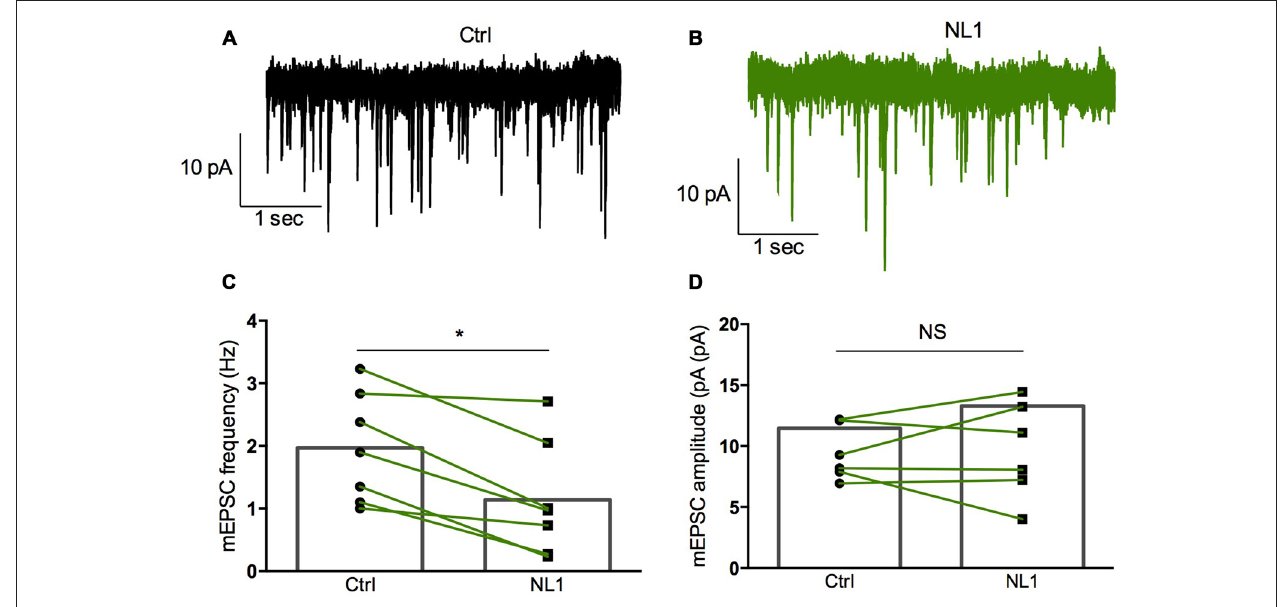
FIGURE 4 | Miniature EPSCs (mEPSCs) are inhibited by ecto-NL1. (A) Example of mEPSC recorded in a pyramidal neuron from CA3 region. Five superimposed recordings. (B) Recording from the same neuron after a single puff of ecto-NL1 near the apical dendrite of the recorded neuron (five superimposed traces). Note the strong decrease in the frequency of mEPSCs. (C) Mean frequency of mEPSCs in control conditions and after ecto-NL1 puff. Significant decrease (mean frequency of mEPSCs in control conditions: 1.97 ± 0.3 Hz; after ecto-NL1: 1.14 ± 0.3 Hz; n = 7 cells; p = 0.015, Wilcoxon matched-pairs signed rank test). (D) No change in the amplitude (mean amplitude of mEPSCs in control conditions: 11.46 ± 2.17 pA; after ecto-NL1: 13.29 ± 3.87 Hz; n = 7 cells; one of the pairs is not visible on the plot; p = 0.47, Wilcoxon matched-pairs signed rank test. Bars show the mean values and lines correspond to individual pairs of